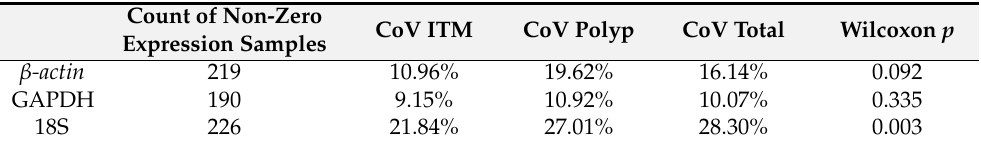
Table 2. Coefficients of variations (CoV) calculated for inferior turbinate mucosa (ITM), polyp, and all samples. Assessed differences for cycle thresholds between polyp and inferior turbinate mucosa samples are presented as Wilcoxon p values.